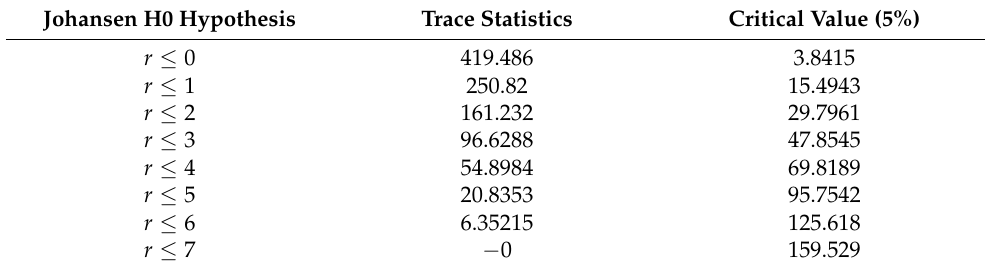
Table 6. Johansen test with ACE results for industrial case.